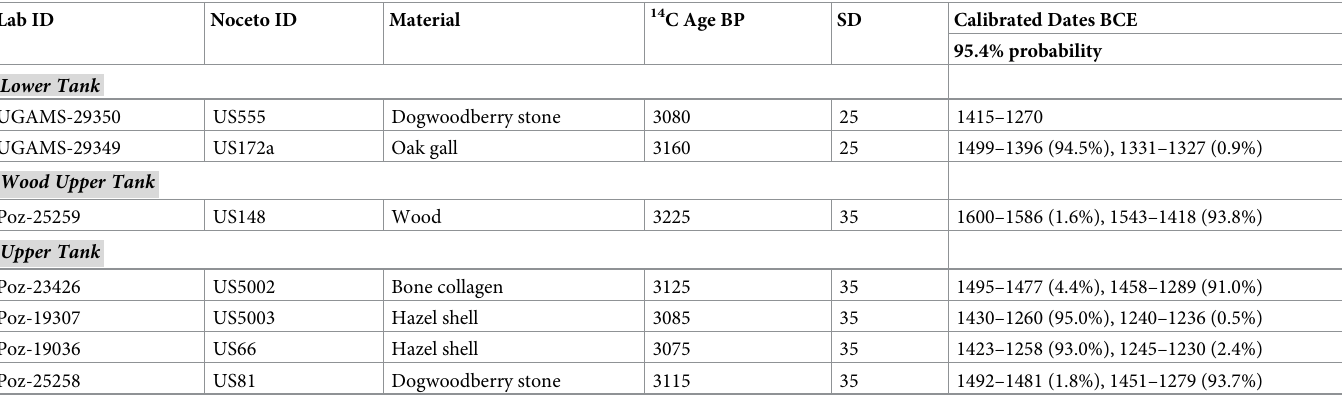
The ring counts (measured rings) of the 25 oak samples range from 71 to 281, with a ring count of over 150 in 19 samples (Table 2). The comparison of ring-width sequences of the oak Table 4. 14 C dates run on other samples from the Noceto upper and lower tanks. Lab